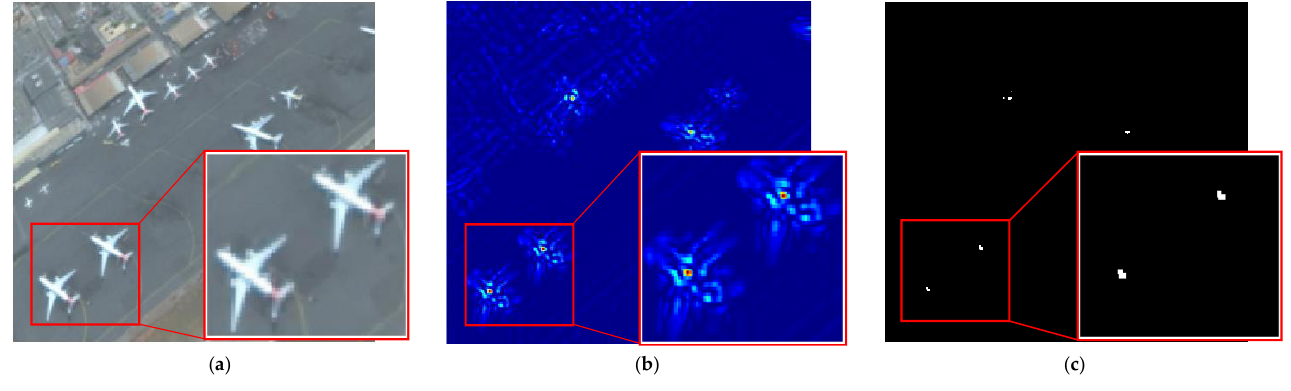
Figure 5. The Original RSI and the process of target center determination. ( a ) The original RSI with the resolution of 1121 × 957 pixels; ( b ) the corresponding center-response magnitude map generated by a convolution kernel ( r = 20 pixels); ( c ) the binary image with the center of targets obtained by threshold segmentation.